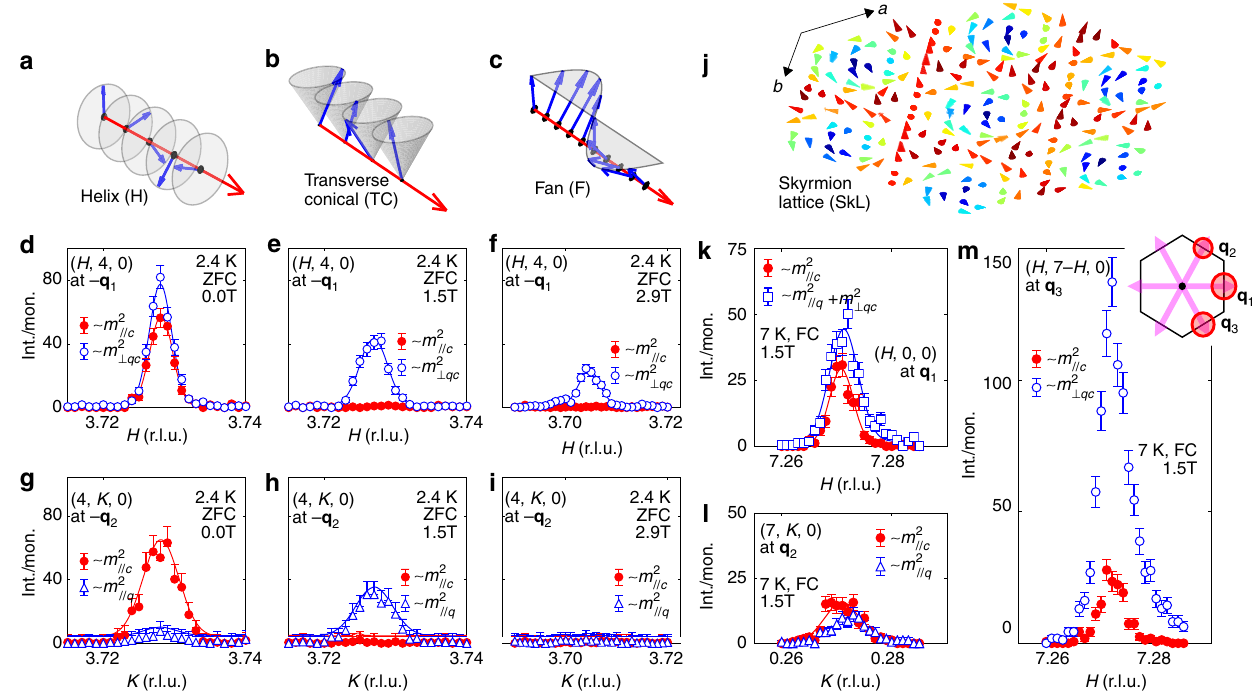
Fig. 3 Resonant elastic x-ray scattering (REXS) with polarization analysis clari fi es the magnetic order of bulk Gd 3 Ru 4 Al 12 . The scattering plane is ( H , K , 0). Blue open symbols correspond to I πσ scattering intensity, related to magnetization components in the hexagonal basal plane ( m 2 //q , m 2 ⊥ q,c ), while red solid symbols are for I ππ intensities, proportional to m 2 //c . Data in ( d – i ) were obtained in the zero- fi eld cooled (ZFC) state, whereas ( k – l ) report fi eld-cooled (FC) measurements. a – i The comparison of scattering intensities at (4- q , 4, 0) and (4, 4- q , 0) re fl ections allows us to separate the two in-plane components m //q and m ⊥ q,c for the three magnetic orders sketched in ( a – c ), observed in the sequence ( a - b - c ) as the magnetic fi eld is increased starting from the ZFC state at T = 2.4 K. Only the helical state in ( d , g ) has m //c ≠ 0. k – m At T = 7 K and μ 0 H int = 1.5 T, the fan-like state coexists with helical modulations under FC conditions. As the fan-like state has m //c = 0, I ππ scattering directly probes the helical component. Comparable magnitude of I ππ ~ m 2 fl ections around (7, 0, 0) is consistent with multi- q helimagnetic order. The nano-scale skyrmion lattice (SkL) //c at the three incommensurate re proposed here is sketched in ( j ), with each cone representing the magnetic moment on an individual Gd-site. Red (blue) correspond to positive (negative) m fi nement of the Gd-site moment, ( j ) visualizes but one possible manifestation of the SkL order. z component of the local moment. Due to the lack of full re Inset of ( m ), red circles of radius r i ~ √ I ππ ~ m //c , illustrating approximately equal weight for the three directions q 1 , q 2 , and q 3 marked by light pink arrows. Error bars correspond to one standard